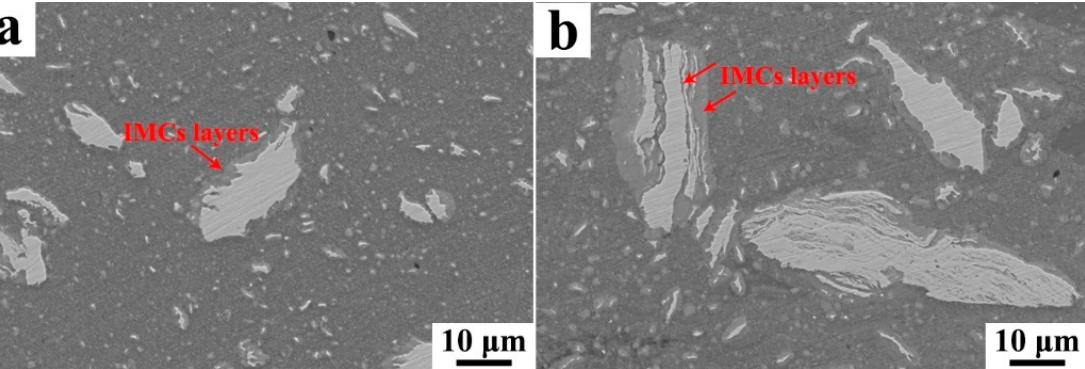
Figure 7. The IMC layers ( a ) surrounding and ( b ) separating the broken steel particles in the NZ.